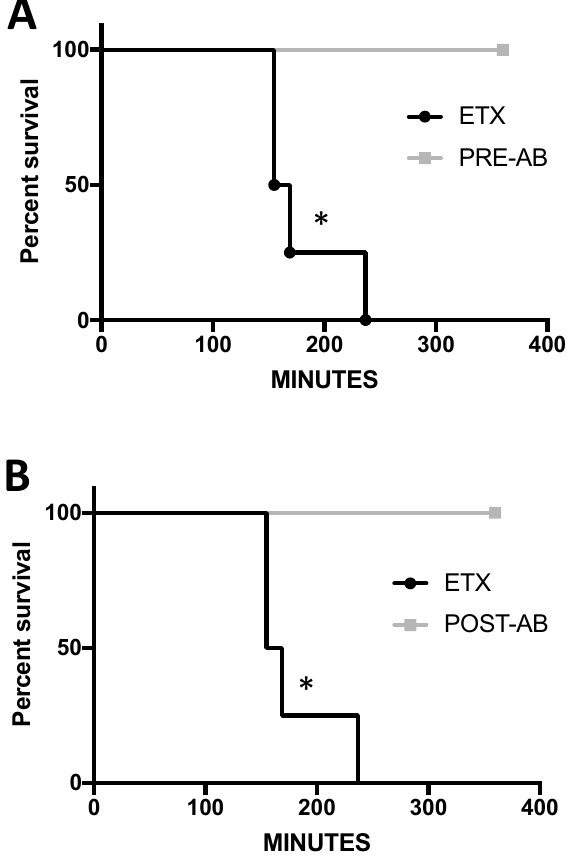
Figure 10. Anti-ETX antibody protects mice from ETX-induced central nervous system (CNS) symptoms in vivo. Mice were treated ETX via intraperitoneal injection. To determine if anti-ETX antibody JL008 could protect against ETX-induced CNS symptoms and death, mice were either treated with ( A ) JL008 30 min prior to ETX treatment (PRE-AB, n = 3) or ( B ) one hour post-treatment via intravenous injection (POST-AB, n = 3). Mice treated with ETX and intravenously injected with saline were used as controls (ETX, n = 4). Animal were observed for up to 360 min post-ETX treatment. Antibody treatment prior to and post-ETX treatment prevented ETX-induced CNS symptoms and death compared to ETX-treated control animals. The same control ETX group was used for both comparisons. * p < 0.02 determined by Log-Rank (Mantel-Cox) test.